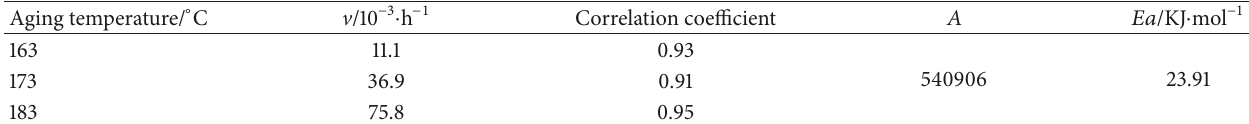
Table 3: Dynamic parameters of aging reaction of modified asphalt.